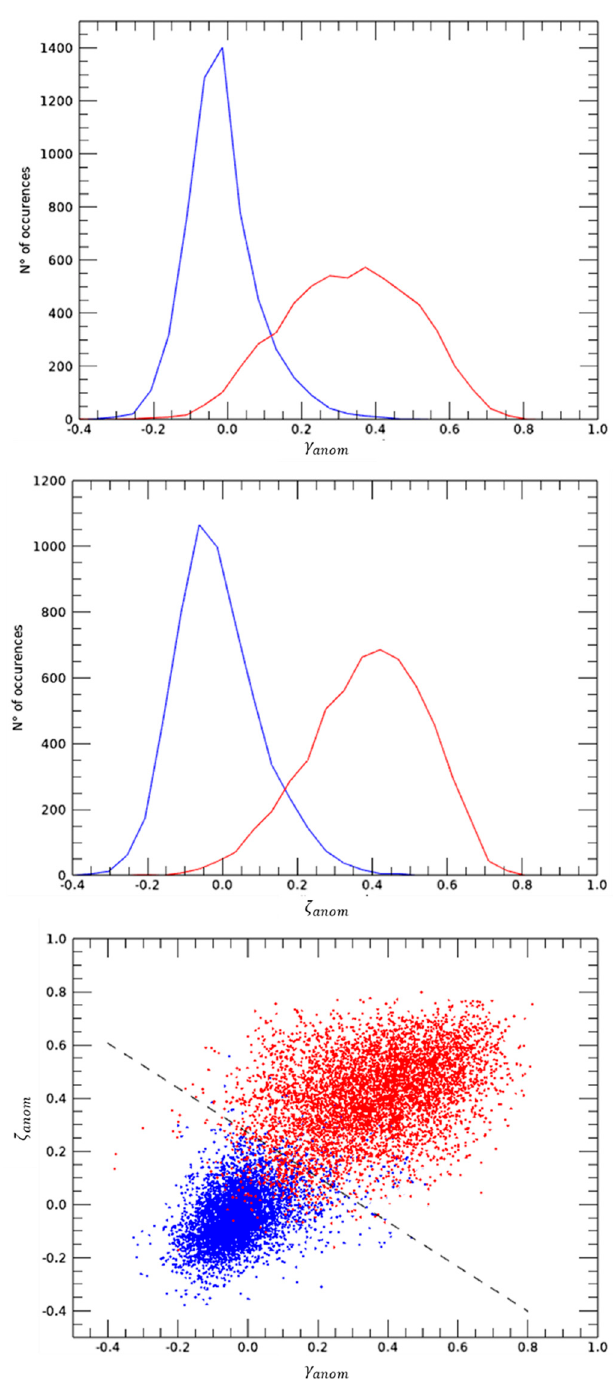
Figure 7. Statistical distribution of the values of γ anom (upper panel) and ζ anom (central panel) in the PSs and scatterplot of γ anom versus ζ anom (lower panel). Blue lines and dots: data derived from the pair of images acquired on 9 March and 21 March under non-flooded conditions; red lines and dots: data derived from the pair of images acquired on 26 April–8 May, 2018 under flooded conditions (except for the PSs included in the Kutimbo district whose data were derived from the pair 14 April–26 April, 2018).